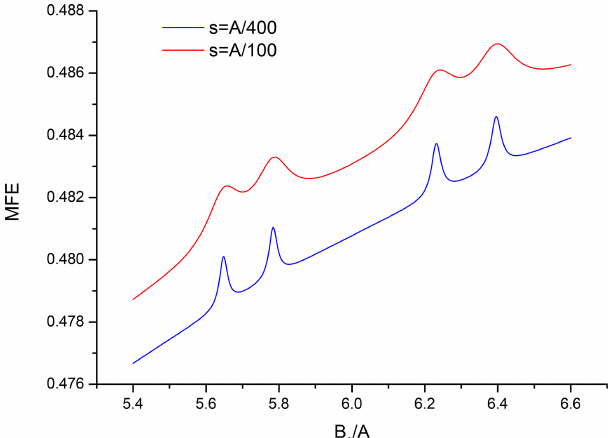
Figure 5. Region in the vicinity of B 0 = 6 A for a pair with six equivalent spin- 1 nuclei with HFC constant A in one partner and 2 two non-equivalent spin- 1 nuclei with HFC constant A/ 10 and 2 A/ 40 in the second partner, recombination parameter s = A/ 100, s = A/ 400.